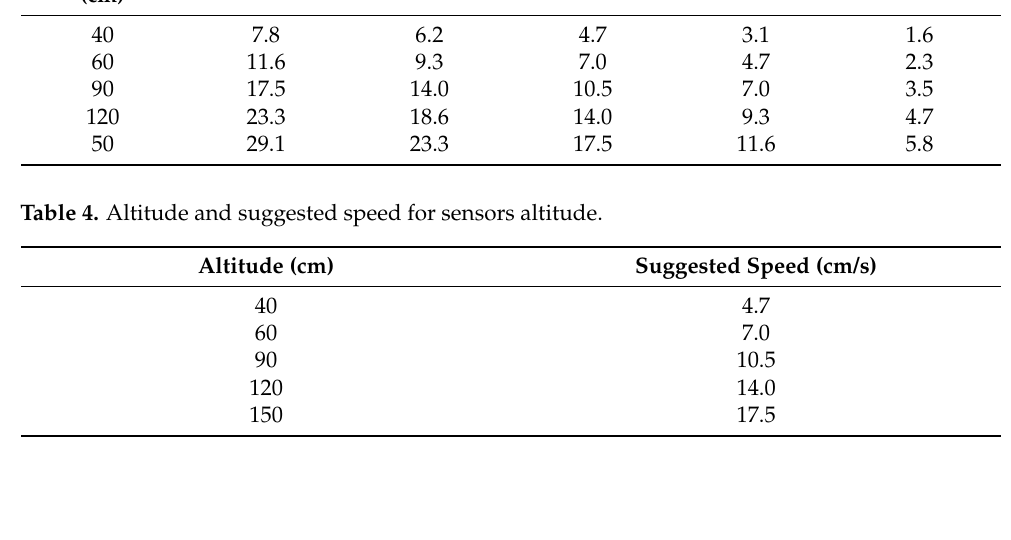
Table 3. Determining speed (cm/s) for various overlapping % at different altitude.